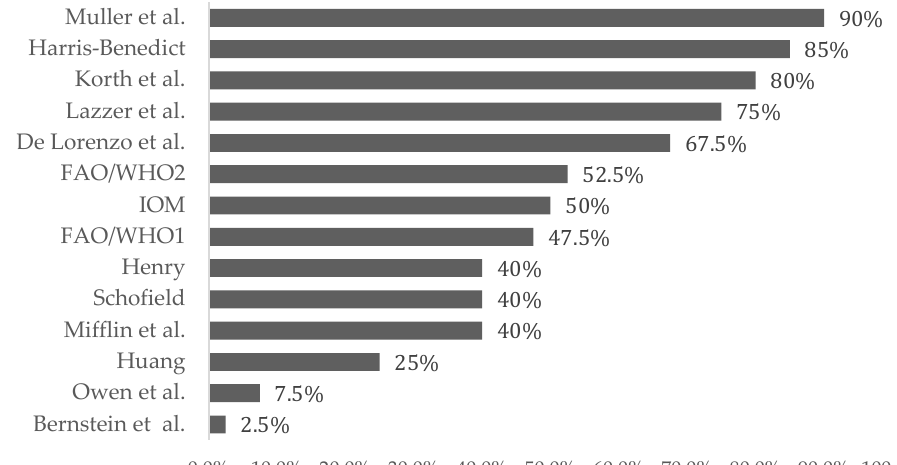
Figure 2. Percent of REE estimates with an individual bias (%) within ± 10% of the estimated REE for each prediction equation. FAO/WHO1—only weight. FAO/WHO2—including weight and height. The correlation between eREE and pREE using the Bland-Altman method is shown in Figure 3.